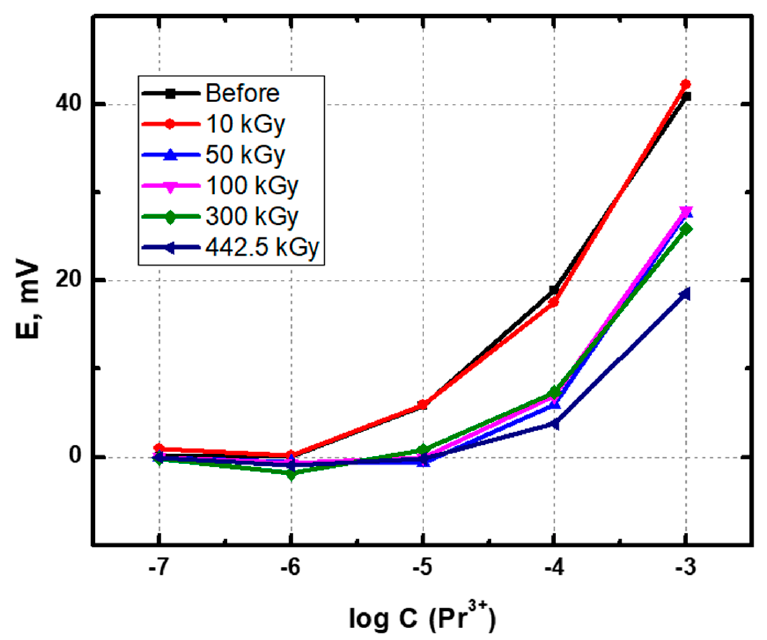
Figure 1. The response curves of the sensor i6 before and after the accumulation of the different absorbed radiation doses. Table 2. Potentiometric sensitivity of the sensors after accumulation of various absorbed radiation doses ( ± 1